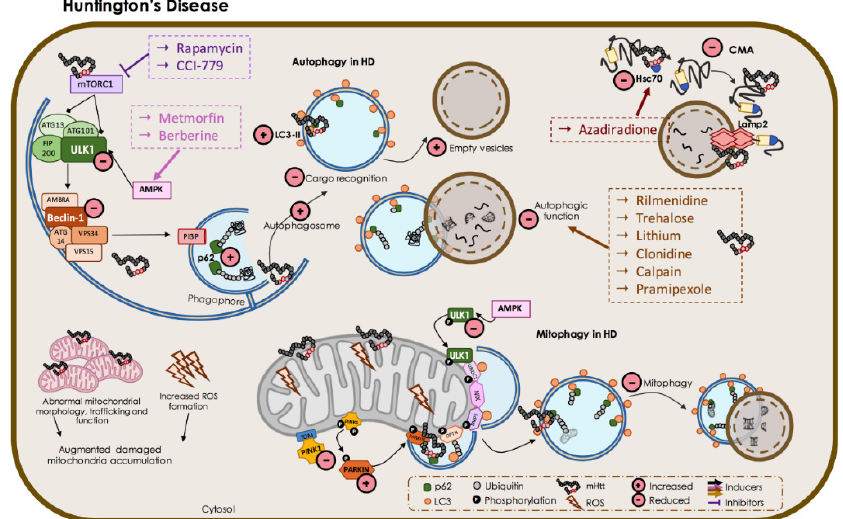
Figure 6. Overview of altered regulation of autophagy and mitophagy mechanisms in HD—role of protective compounds. Autophagic activity and related proteins are decreased in HD. Indeed, inducers of autophagic activity (referred to in the dashed box, in brown) were shown to significantly improve HD features in different HD models. The mTORC1 inhibitors and the AMPK inducers were shown to be protective in HD (referred to in the dashed boxes, in purple and pink, respectively), promoting autophagy. Several HD models showed increased autophagosome accumulation with reduced cargo recognition and accumulation of empty vesicles. Mitophagy is also impaired in several HD models. HD